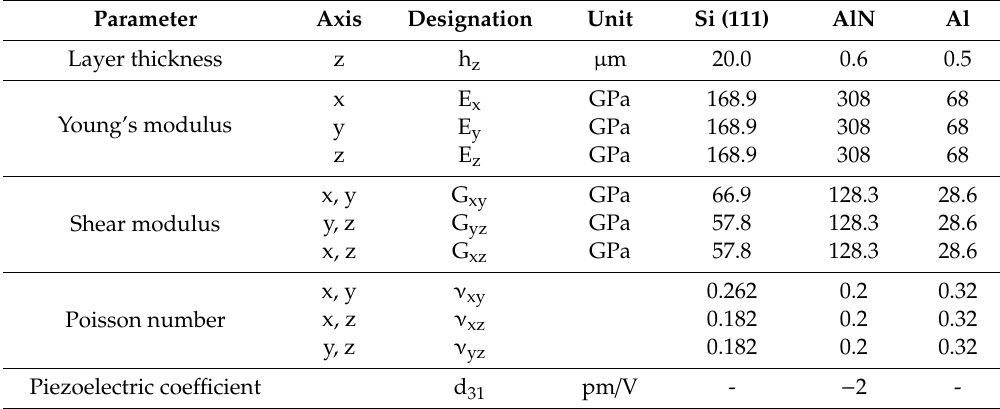
Table 2. Parameter set for micromirror design and modeling [18–23].